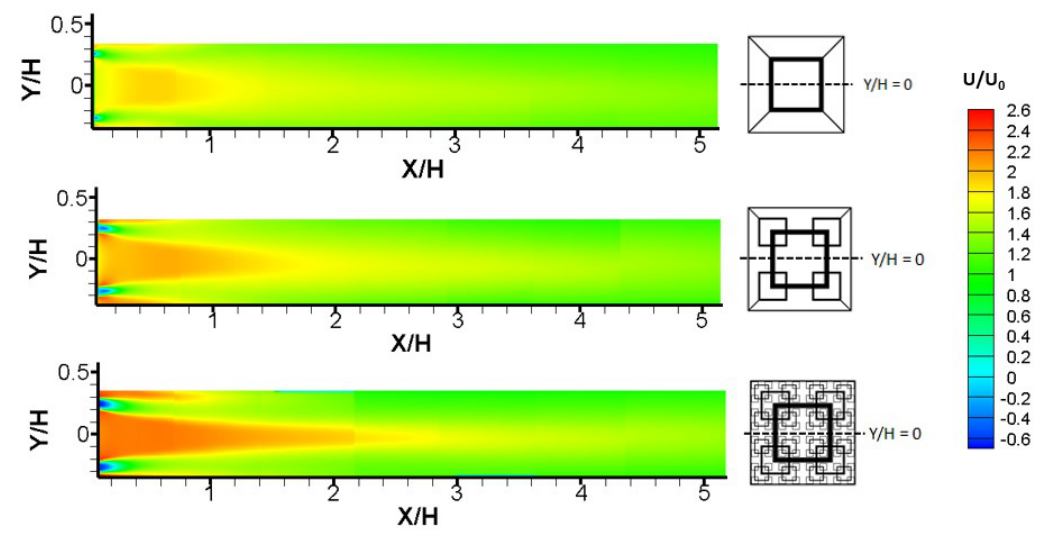
Figure 4. Mean streamwise velocity U / U 0 downstream of a fractal square grid at Re = 3400. FG1, FG2 and FG4 from top to